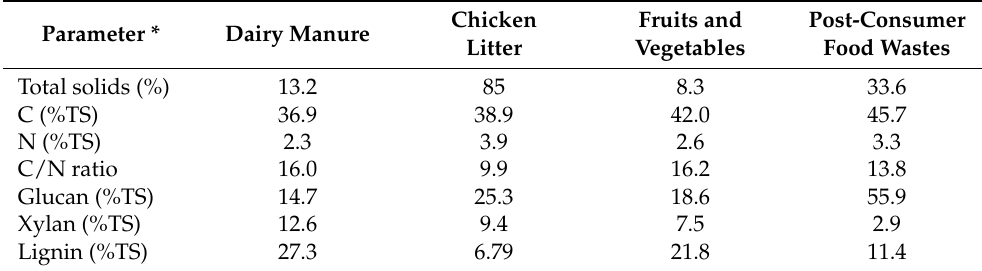
Table 1. Characterization of the substrates used in the experiment.